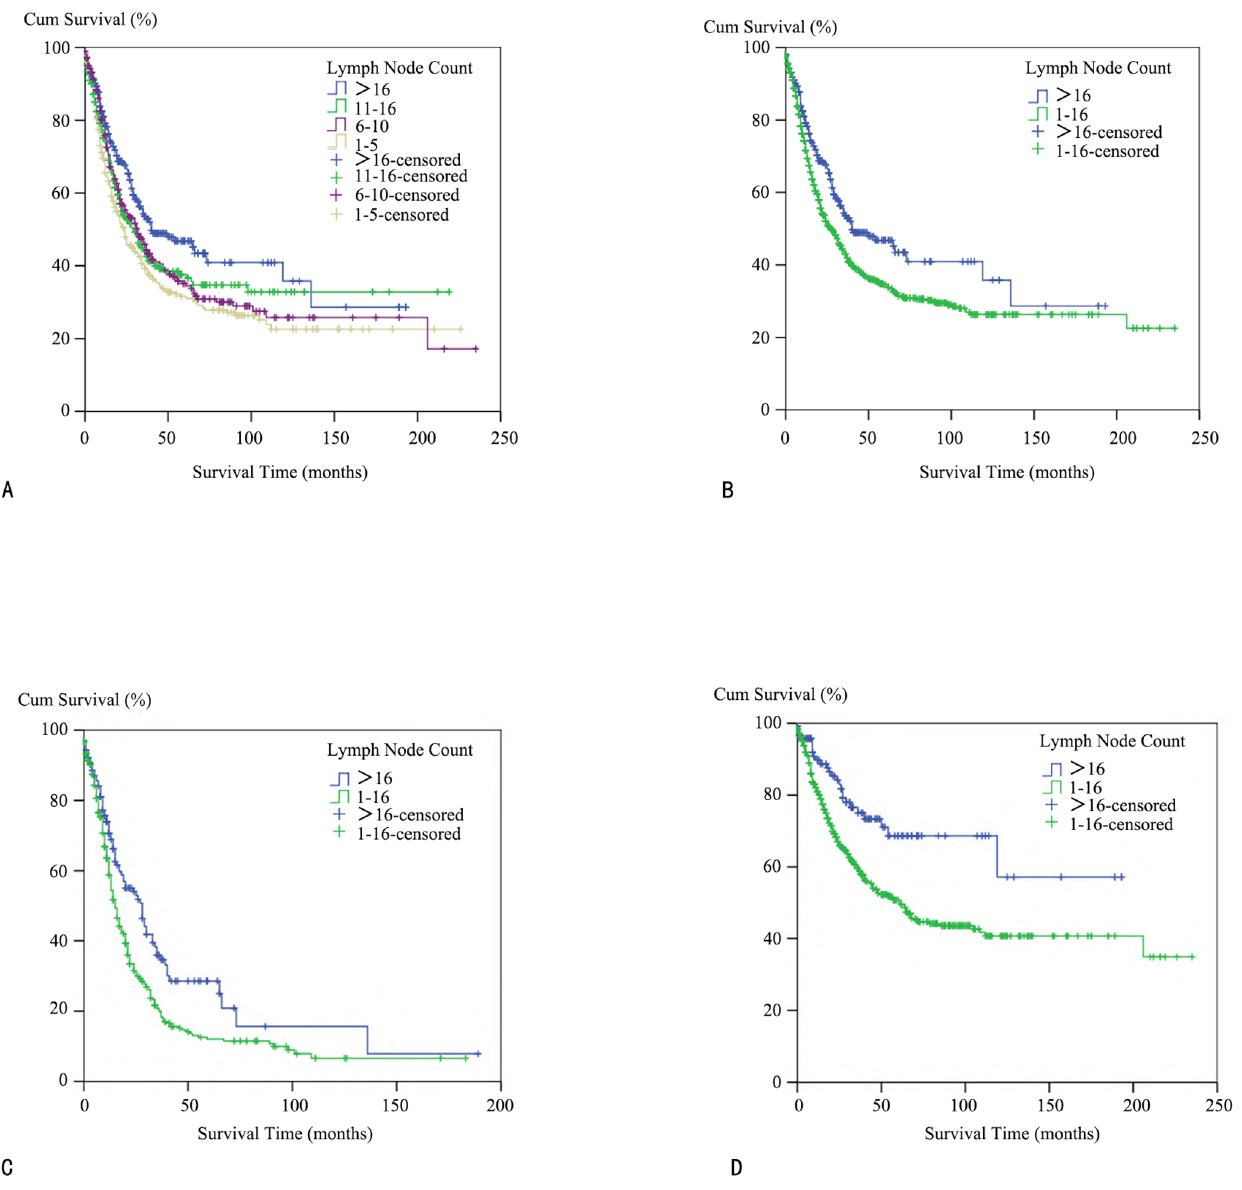
Figure 1. Kaplan–Meier survival analysis for invasive IPMN patients with different lymph node counts. (A) A cancer-specific survival (CSS) curve for patients with lymph node count of 1–5, 6–10, 11–16 and over 16. (B) A cancer-specific survival (CSS) curve for patients with lymph node counts of 1–16 and over 16. (C) A cancer-specific survival (CSS) curve for N1 patients with lymph node counts of 1–16 and over 16. (D) A cancer- specific survival (CSS) curve for N0 patients with lymph node counts of 1–16 and over 16.